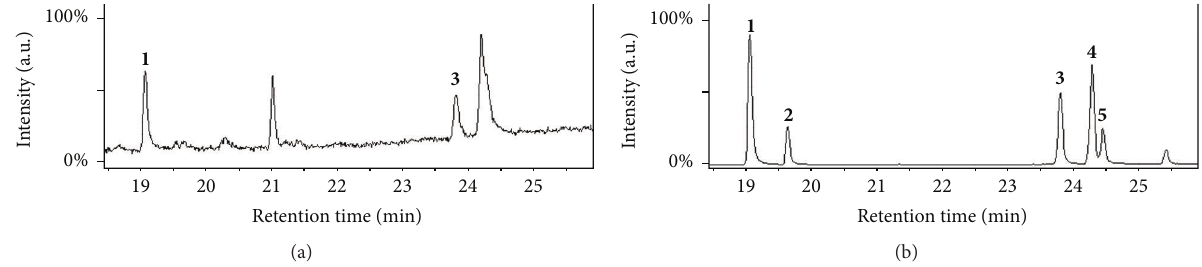
Figure 2: GC-MS analysis of fatty acids from cell extracts of S. solfataricus . Total Ion Chromatograms (TICs) of fatty acids are shown for S. solfataricus cell extracts (a) and lipid standard (b) as analyzed by GC-MS. Two lipids were positively identified from this analysis, matching gas chromatogram retention times and fragmentation patterns of known standards from the NIST database. GC peaks are labeled as follows: 1 , hexadecanoic acid (C16:0); 2 , hexadecenoic acid (C16:1); 3 , octadecanoic acid (C18:0); 4 , octadecenoic acid (C18:1); and 5 , octadecadienoic acid (C18:2). The unlabeled peaks could not be positively identified but are believed to be due to instrument or solvent background based on NIST database